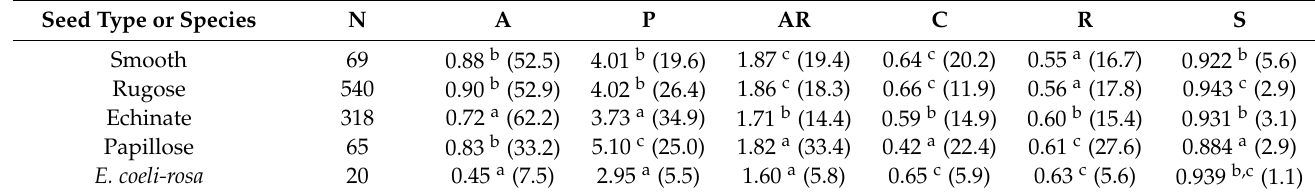
Table 3. Results of Kruskal–Wallis post hoc tests based on individual silhouettes for the comparison of the dorsal seed views between the four morphological groups of seeds (smooth, rugose, echinate, and papillose), and Eudianthe coeli-rosa . Mean values and coefficient of variation (given in parentheses) are indicated for area (A), perimeter (P), aspect ratio (AR), circularity (C), roundness (R) and solidity (S). Values marked with the same superscript letter in each column correspond to populations that do not differ significantly at p < 0.05 (Campbell and Skillings test). N indicates the number of seeds